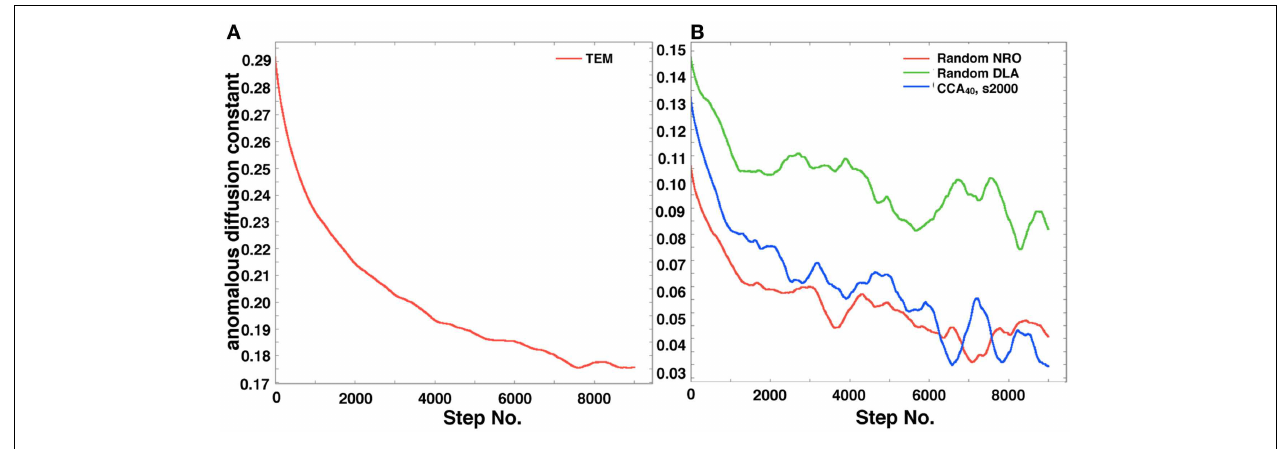
anomalous diffusion constant was calculated from its MSD. (B) Anomalous diffusion constant of a mobile particle in each simulated model (random NRO, red; random DLA, green; CCA with 40% of NRO at the 2,000th step,